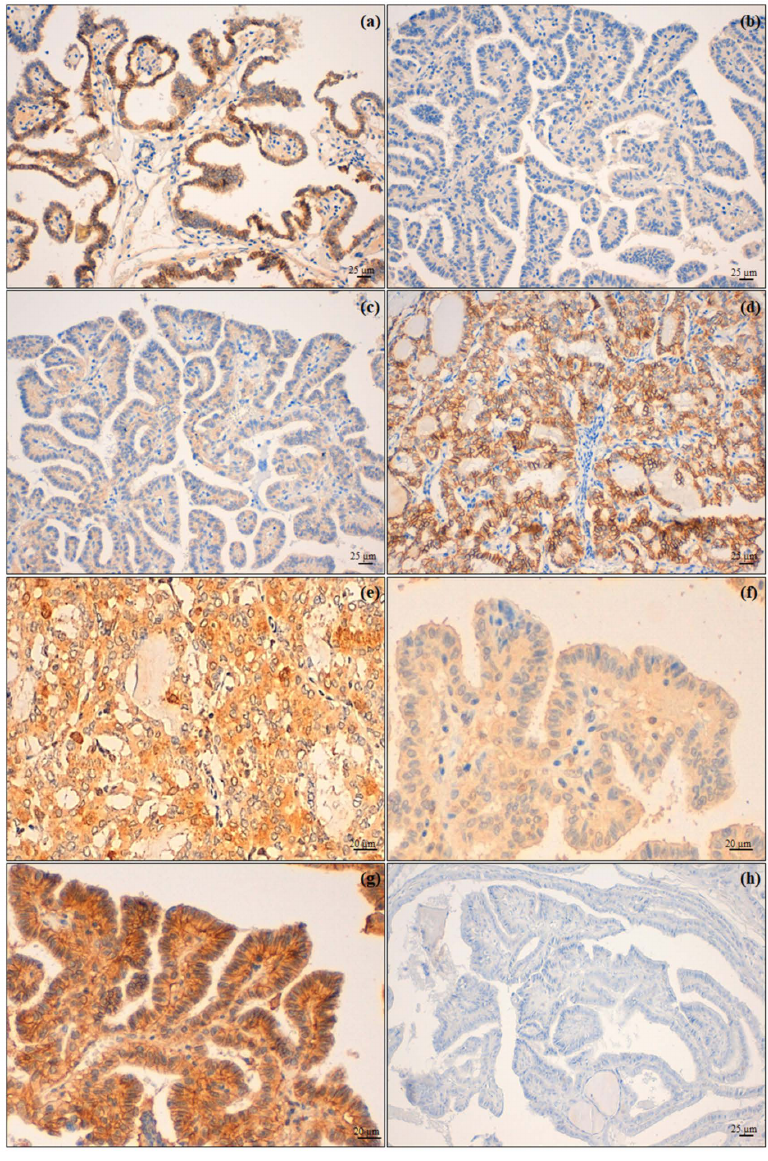
Figure 2. Biomarker immunohistochemical expression. ( a ) Membranous high expression of N- cadherin on tumour cells of PTC infiltrating the airway (PTC-A) compared with ( b ) an intrathyroid PTC (PTC-B); ( c ) PTC-A presented a low expression of E-cadherin and ( d ) PTC-B (follicular variant) with retained expression of this molecule; ( e ) PTC-A showing a high expression of AhR in contrast with ( f ), which shows low expression of the same immunomarker in a PTC-B; ( g ) CD147 high expression of PTC-B and ( h ) absent expression in PTC-A. Original magnification: ( a – d , h ) 200 × ; ( e – g ) 400 ×